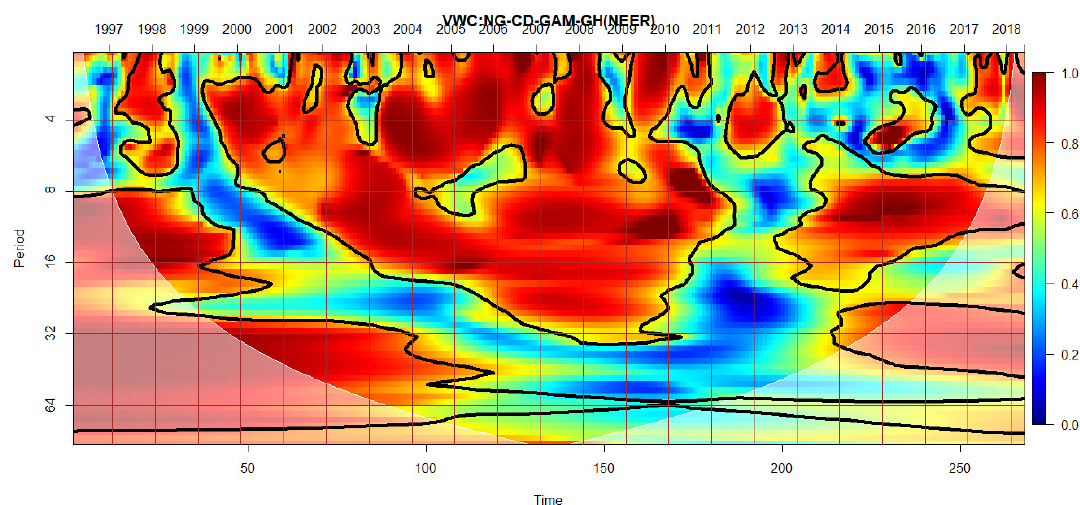
Figure 2. Multiple wavelets among country-level macroeconomic indicators.